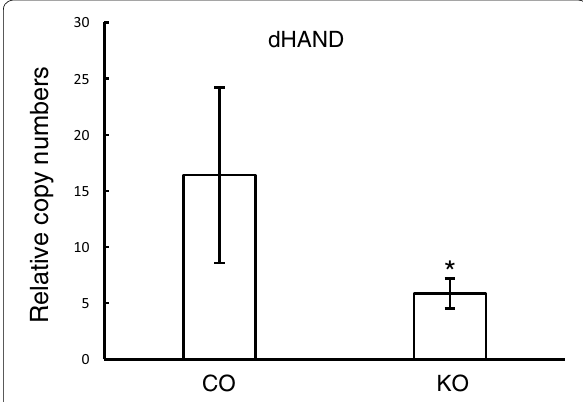
Fig. 3 Real-time PCR analysis of dHand expression levels. The expres- sion level of dHand was significantly decreased in Cdc42 knockout heart. *P <